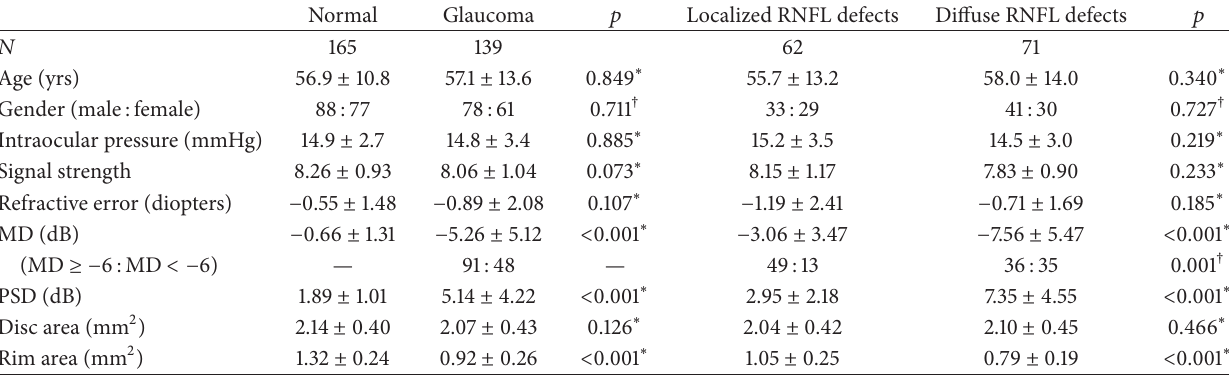
Table 1: Demographic characteristics of study subjects.